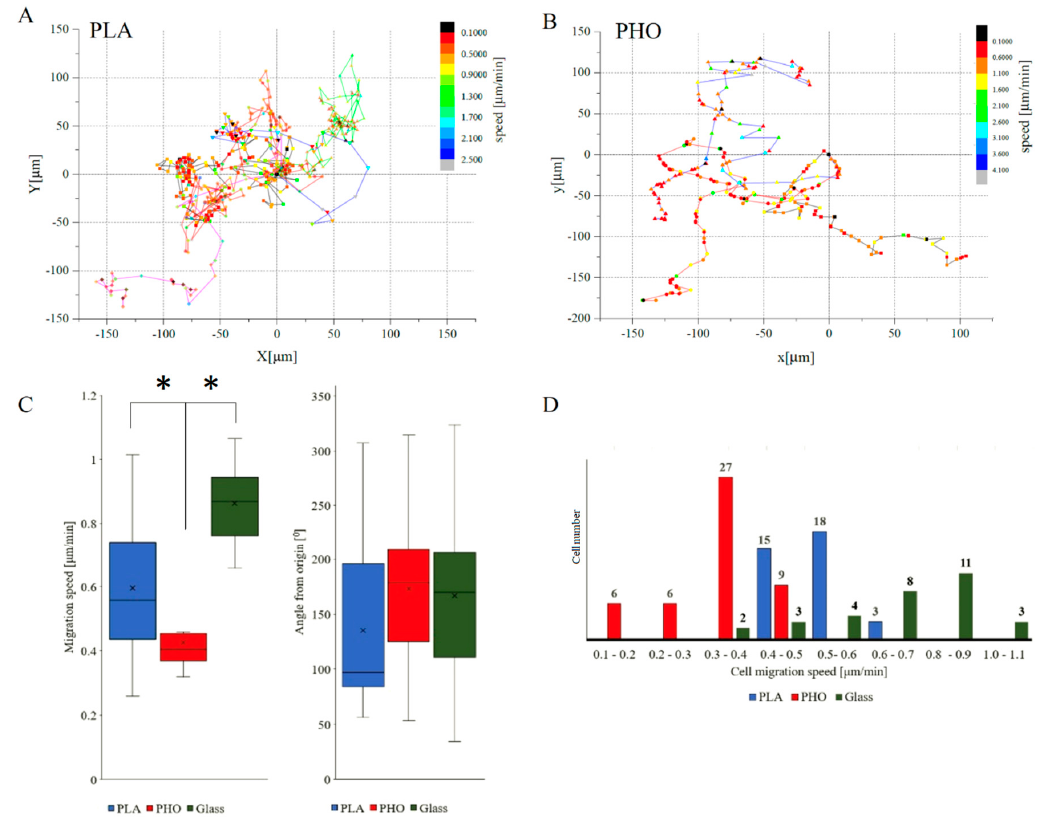
Figure 2. Migration analysis of MEF 3T3 cells grown on PLA and PHO. Selected trajectories of cell movement ( A -PLA, B -PHO) along with instantaneous speeds at each time point, comparison of average velocities and migration angles ( C ) as well as histograms showing the distribution of migration velocities ( D ), numbers over the bars represent number of cells migrating at certain speed range. Data for both biopolymers was compared with glass [21] as reference material. Results statistical significance: * p < 0.05